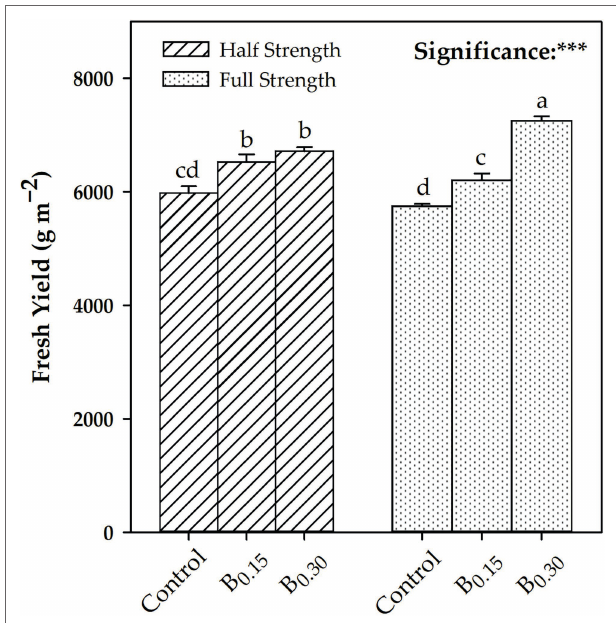
FIGURE 1 | Effects of Biostimulant × Nutrient Solution Concentration interaction for fresh yield [Nutrient solution concentration treatments: Half strength and Full Strength; biostimulant treatments: Control; B0.15 = 0.15 ml L − 1 of Trainer ® ; B0.30 = ml L − 1 of Trainer ® ]. Different letters denote significant differences ( p < 0.05) according to Tukey–Kramer HSD test. ***Significant effect at the 0.001